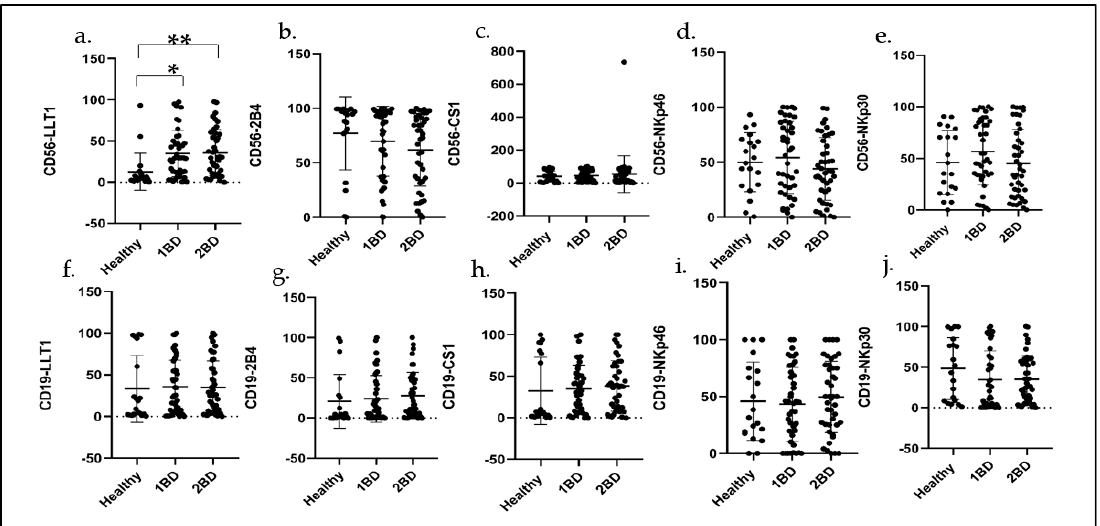
Figure 5. Expression of LLT1, 2B4, CS1, NKp30 and NKp46 on NK and B cells of ALL subjects before and after induction chemotherapy. Flow cytometry analysis exhibit cell surface expression of indicated receptors on ( a – e ) NK cells and ( f – j ) CD19+ B cells of ALL subjects compared to healthy subjects indicated by percentage of positive cells (FL) for the indicated receptors. 1BD, first blood draw indicates sample obtained at diagnosis (day 0). 2BD, second blood draw indicates sample obtained at the end of induction chemotherapy (day 29). * p < 0.05, ** p < 0.01.